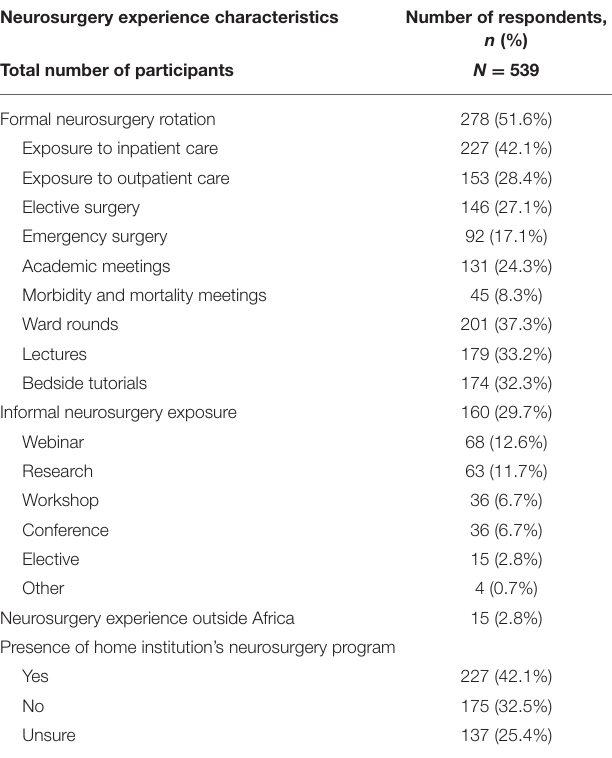
TABLE 2 | Characteristics of neurosurgery experience among African medical students. Neurosurgery experience